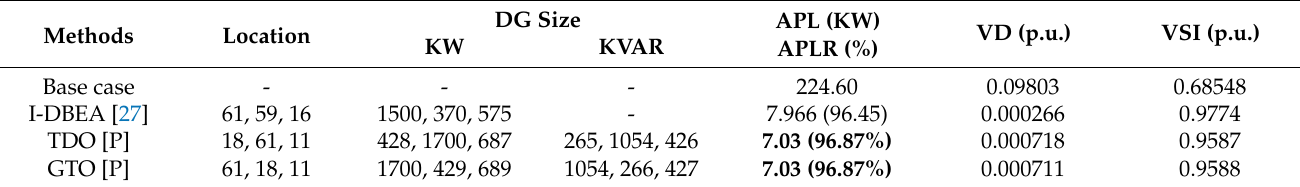
Table 12. Results comparison of OADG for a 69-bus RDN for the SOF (APL minimization) at 0.85 pf (WT type) with a CP load model.